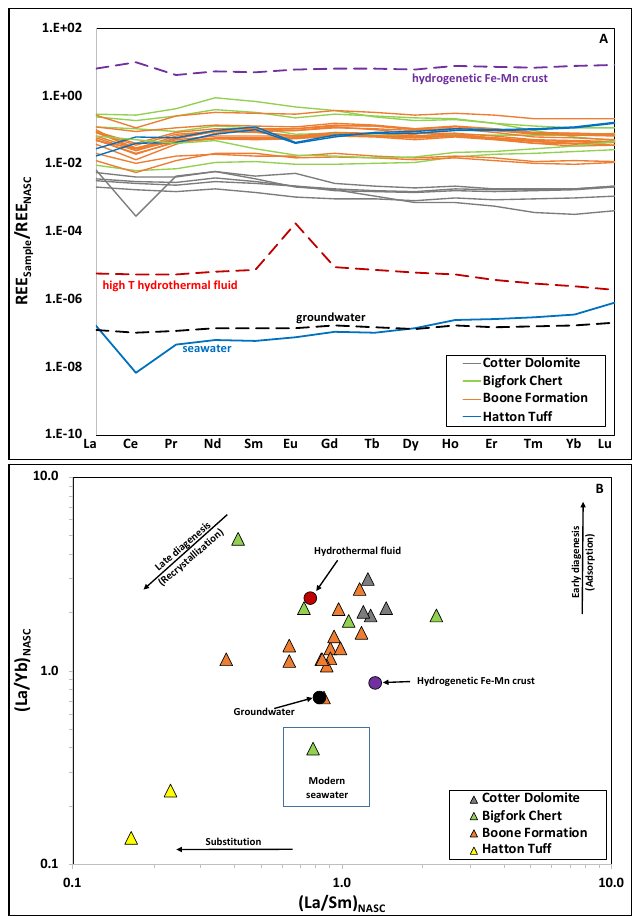
Figure 5. ( A ) North American Shale Composite (NASC)-normalized [72] REE distribution patters in the analyzed samples. Additionally shown are values for seawater [75,76], groundwater from Ash Meadows, Nevada [26], high temperature hydrothermal fluid from the Broken Spur site at the Mid-Atlantic Ridge [77], and hydrogenetic Fe-Mn crust [78]. ( B ) (La/Sm) N vs. (La/Yb) N plot displaying the (La/Sm) N values vs. the LREE-HREE fractionation proxy in the analyzed